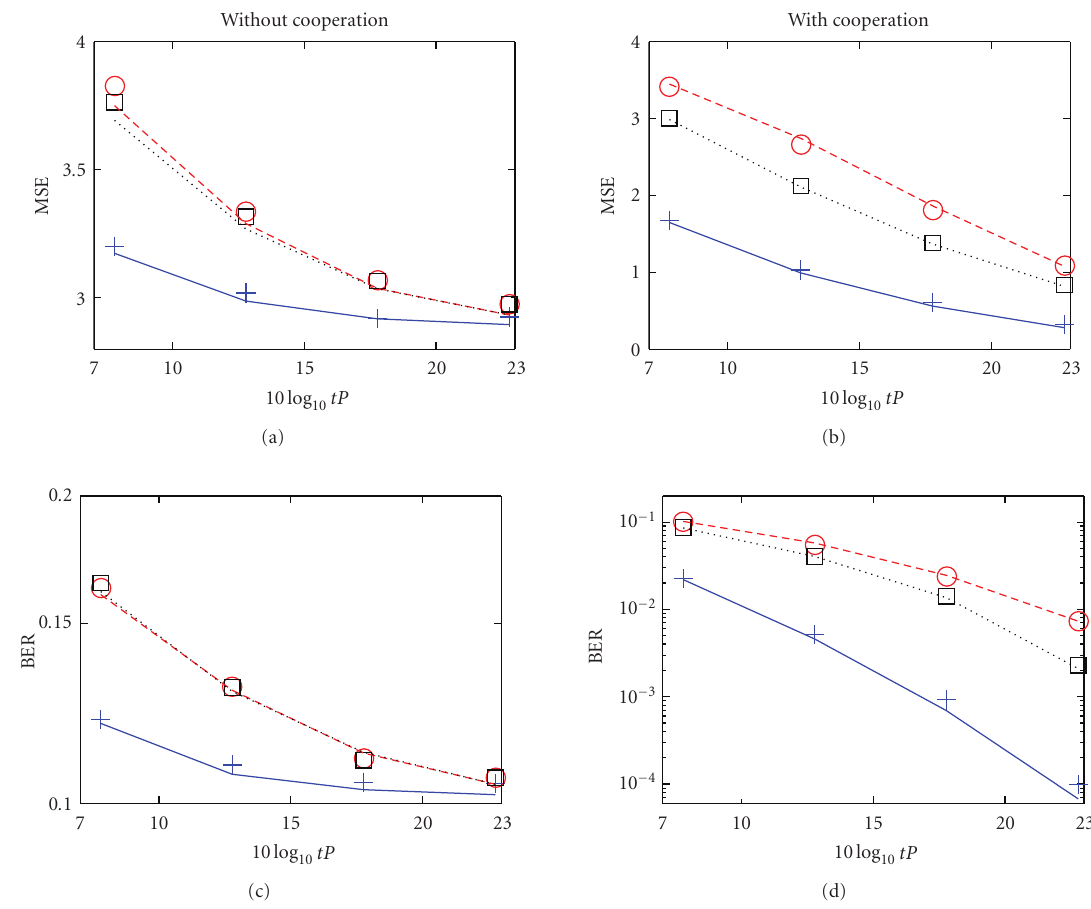
Figure 5: MSE and BER as functions of 10log tP under per-antenna and per-cell power constraints. System parameters and configurations 10 are shown in example 3 of Table 1 and Figure 1(a). ( Legends: the blue solid lines, red dashed lines, and black dotted lines represent, resp., the GIA, the Non-robust-GIA, and the Robust-GIA results under the per-cell power constraint. And the blue plus markers, red circle markers, and black square markers represent, resp., the GIA, the Non-robust-GIA, and the Robust-GIA results under the per-antenna power constraint.